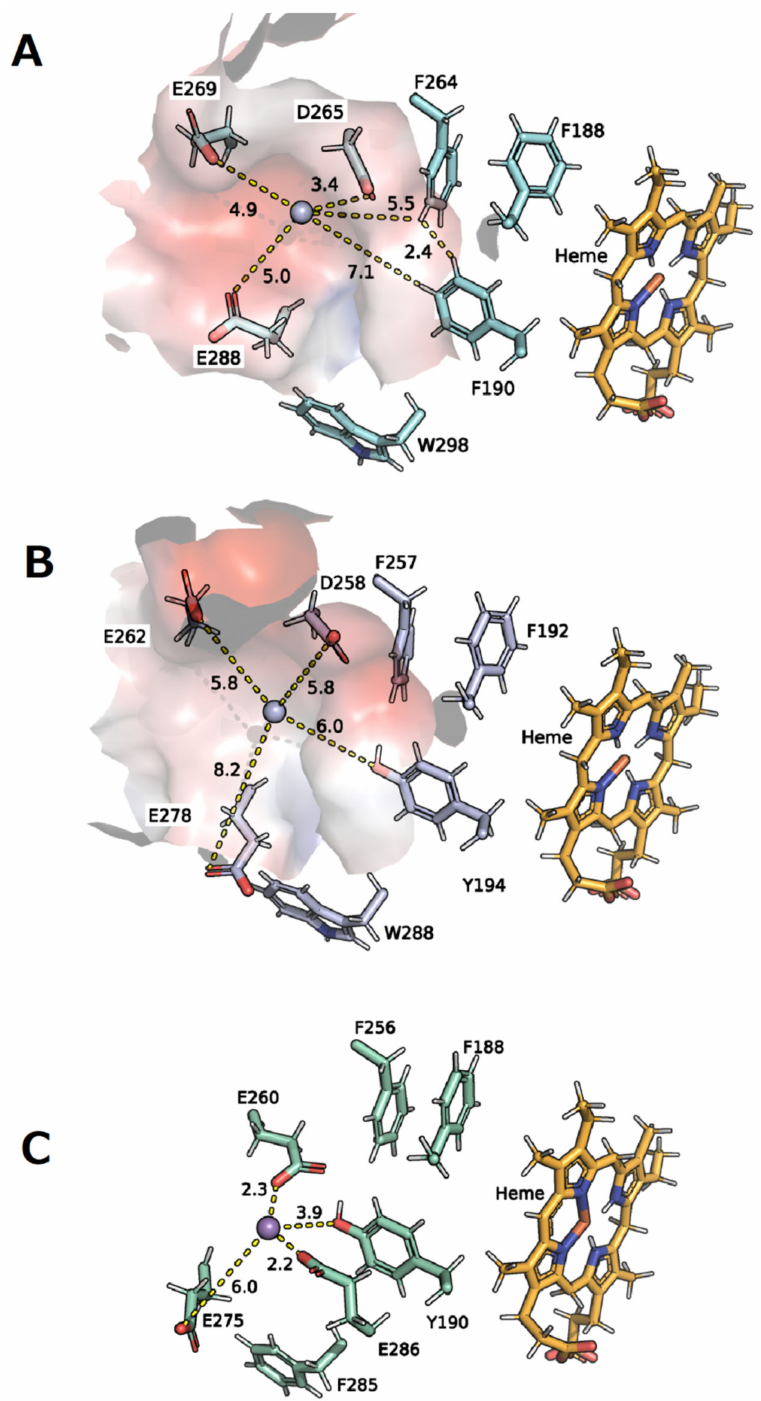
Figure 7. ( A ) Hypothetical Mn 2+ binding site in the protein model of Xgr DyP g488 , in comparison to the characterized structures of the ( B ) fungal r Pos DyP4 (PBD: 6fsk; [56]) and ( C ) the bacterial Asp DyP2 (PBD: